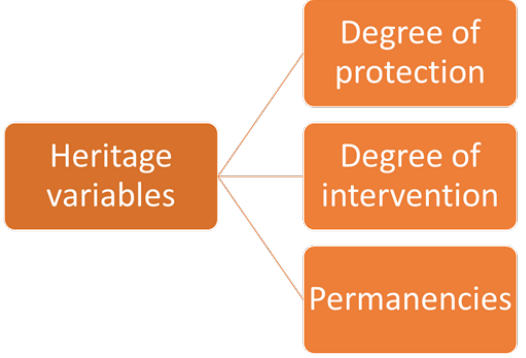
Figure 12. Heritage variables. Own elaboration.